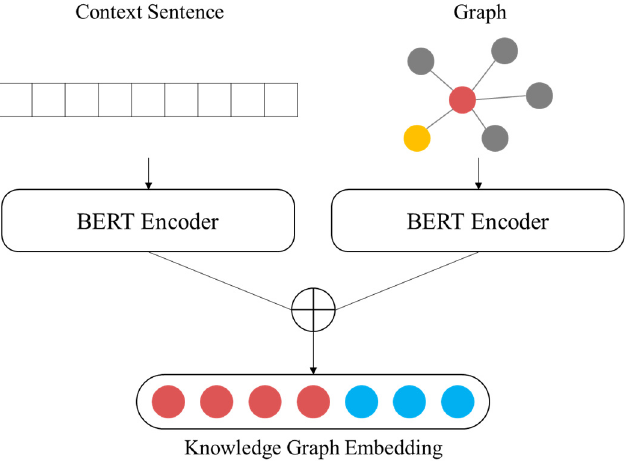
Figure 4. Knowledge graph embedding layer.